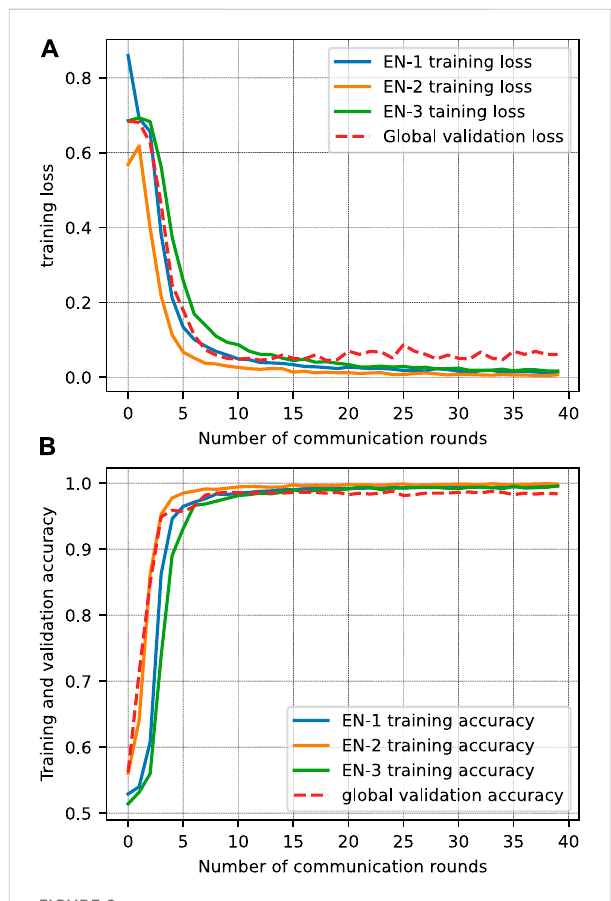
FIGURE 2 The learning curves for proposed VFWN during model training. (A) Training loss of each EN and validation loss for the global model, and (B) training and validation accuracy for ENs and global